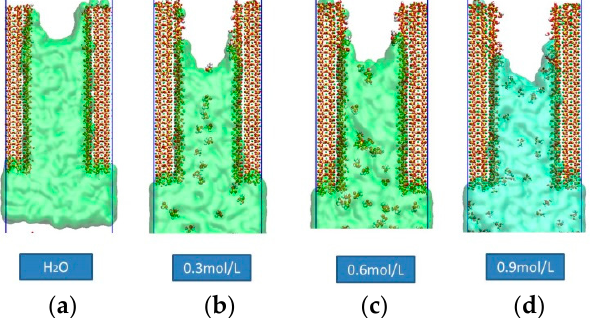
Figure 2. Screenshots of the four models of water molecules at 800 ps.